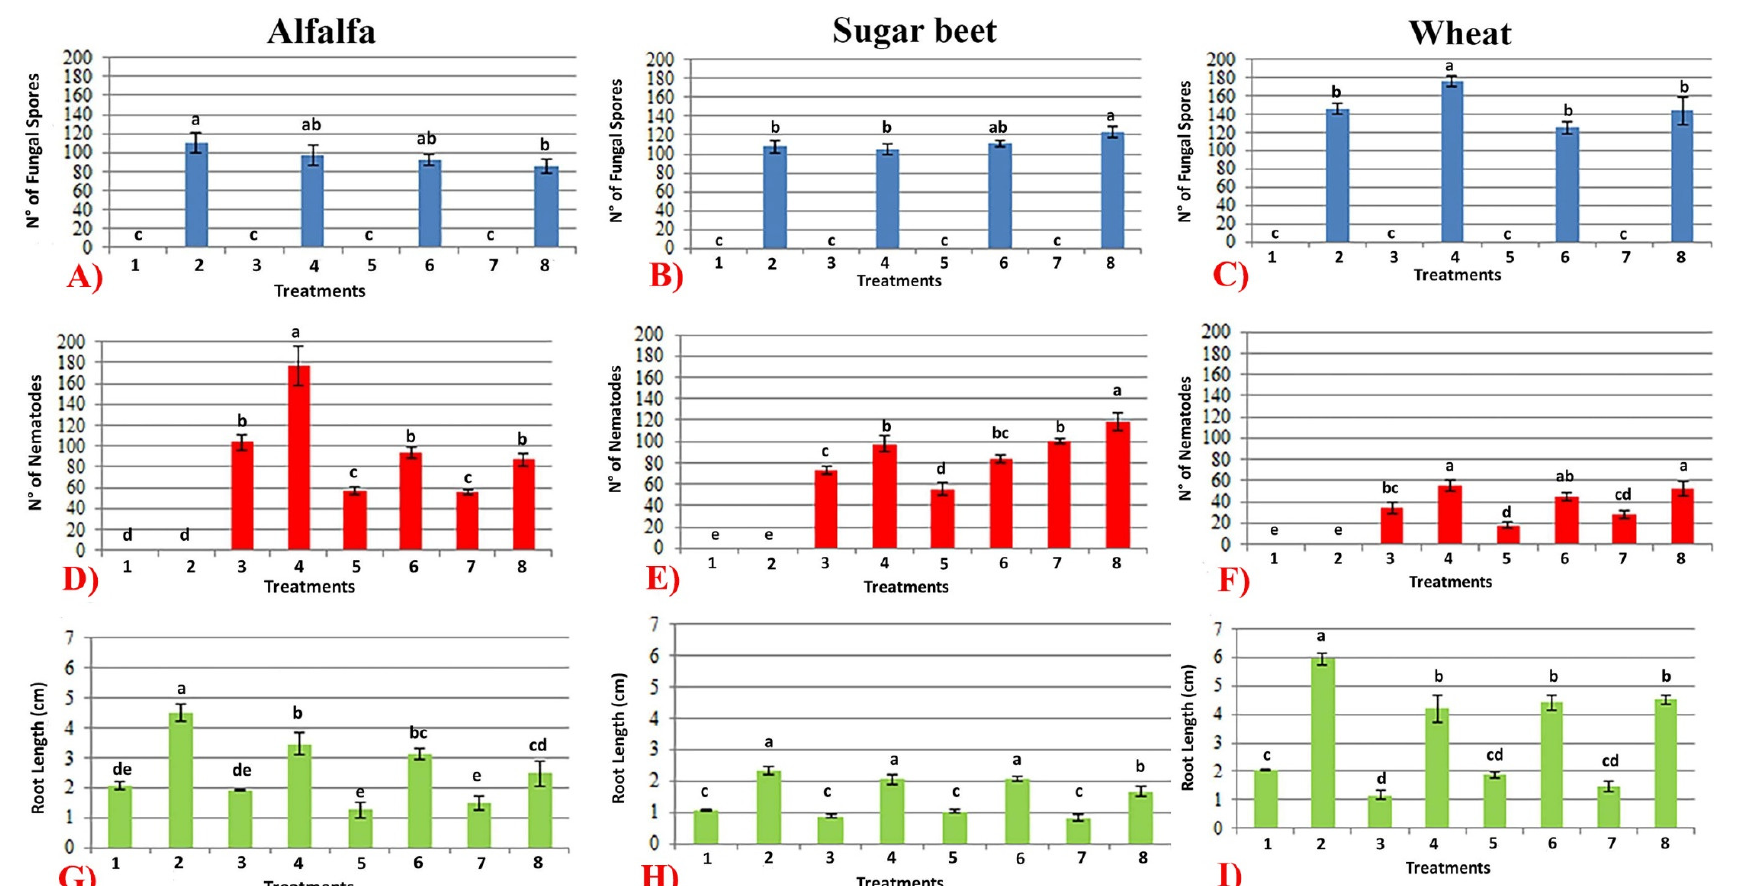
Figure 5. Main effects of arbuscular mycorrhizal fungi (AMF) and criconematids treatments on the number of fungal spores ( A – C ), nematodes ( D – F ), and root length ( G – I ) of the three host plants. The treatments are indicated with numbers as follow: 1: without AMF and nematodes inoculation; 2: with AMF inoculation but without nematodes; 3: without AMF but with M. antipolitanum inoculation; 4: with both AMF and M. antipolitanum inoculation; 5: without AMF but with M. xenoplax inoculation; 6: with both AMF and M. xenoplax inoculation; 7: without AMF but with C. informis inoculation; and 8: with both AMF and C. informis inoculation). The same letters (a–d) indicated in the bars show not significant difference at p < 0.05 based on Tukey’s multiple-comparison